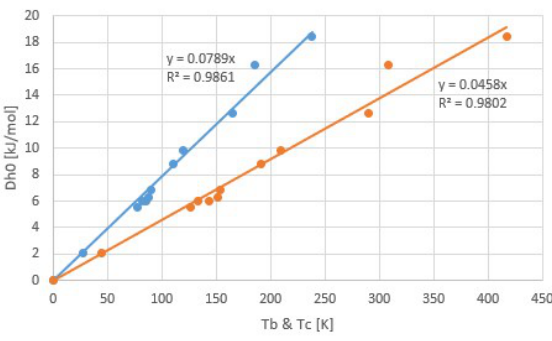
Figure 6. Correlations of latent heat ∆ h versus the normal boiling temperature T b (Trouton’s Rule, blue line) and of ∆ h versus the critical temperature T c (principle of corresponding states, orange line) for some common fluids [17]. For this data, the regression coefficient is not better for the principle of corresponding states than for Trouton’s rule.